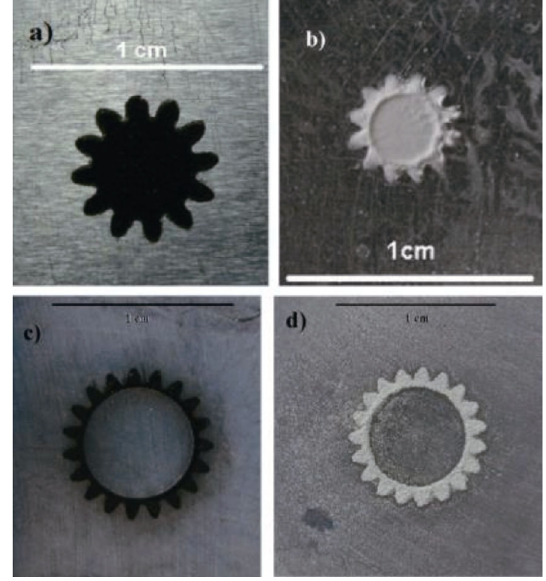
Fig. 20 (a) Micro mould, (b, d) micro-gears before sintering, (c) EPD 1 wt% CNT-reinforced alumina. Reproduced with permission from Ref. [134], © Elsevier